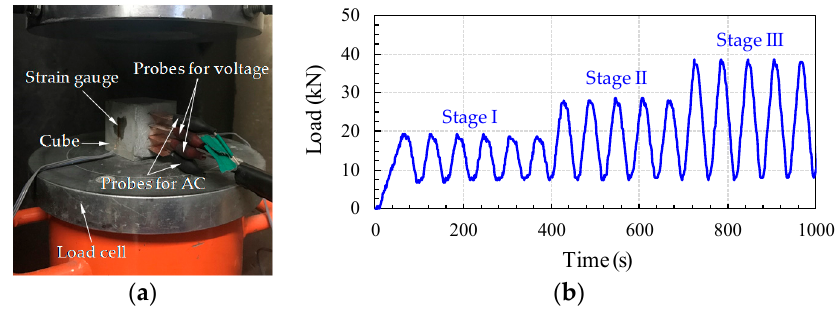
Figure 3. Cyclic compression test; ( a ) experimental set-up; and ( b ) loading protocol [32].